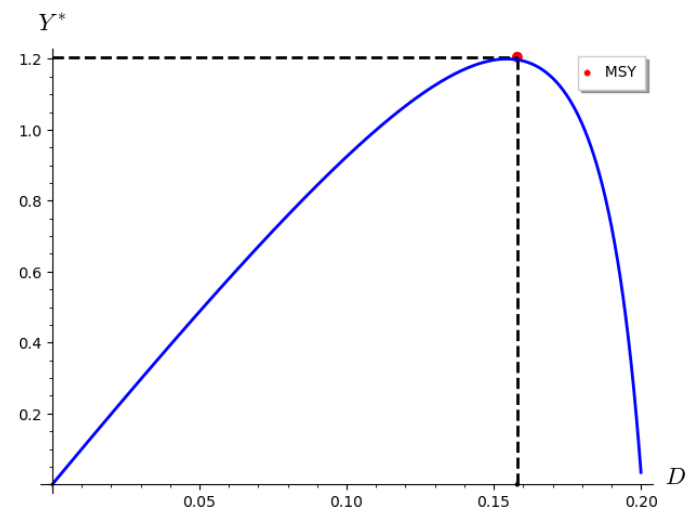
Figure 6. Parameter set: µ = 0.22, u = 0.3, k = 5, s in = 5, graph of function Y ∗ = f ( D )